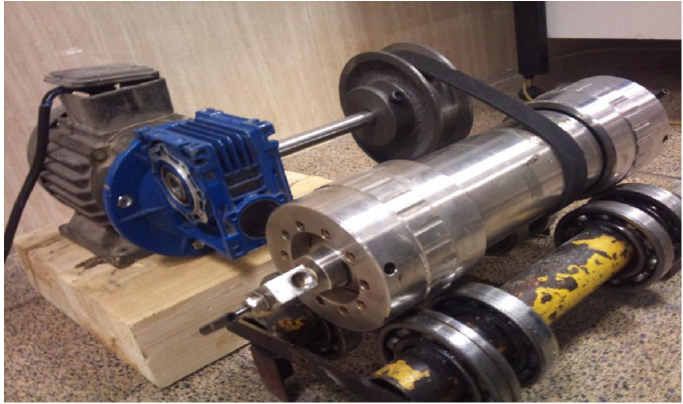
Figure 2. Agitating pump system designed to agitate the high-pressure cylinder in the oven.